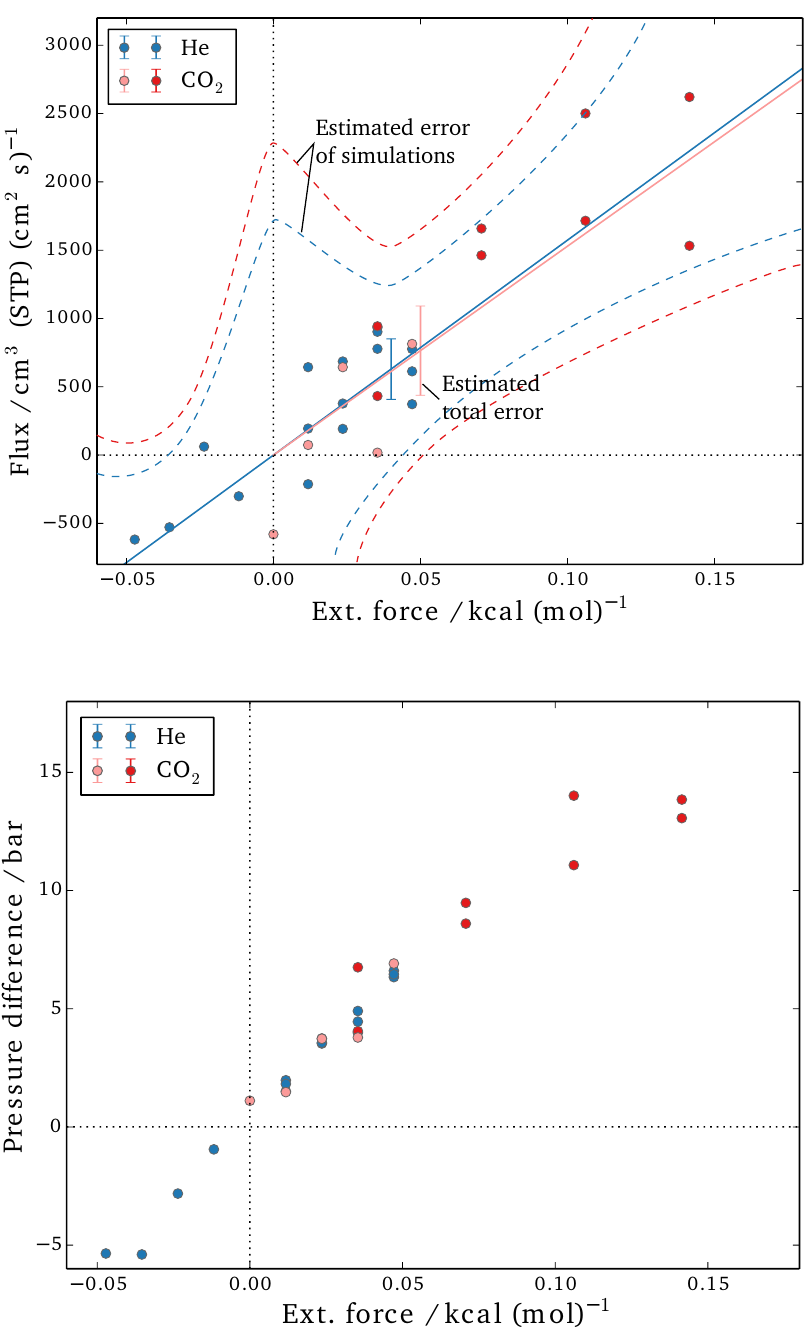
Figure 5. Simulation results for steady-state flux (Top) and the pressure difference between bulk sections (Bottom). Blue circles show the results for helium; red circles show the results for carbon dioxide (dark red represents simulations in which all three sites of the CO molecules were perturbed, and light red symbols show simulations in which only the 2 carbon center felt the external force). The dotted lines in the plot on the left are estimations for the error expected in a single simulation, while the error bars represent the total error of the estimated steady-state flux from simulations at different